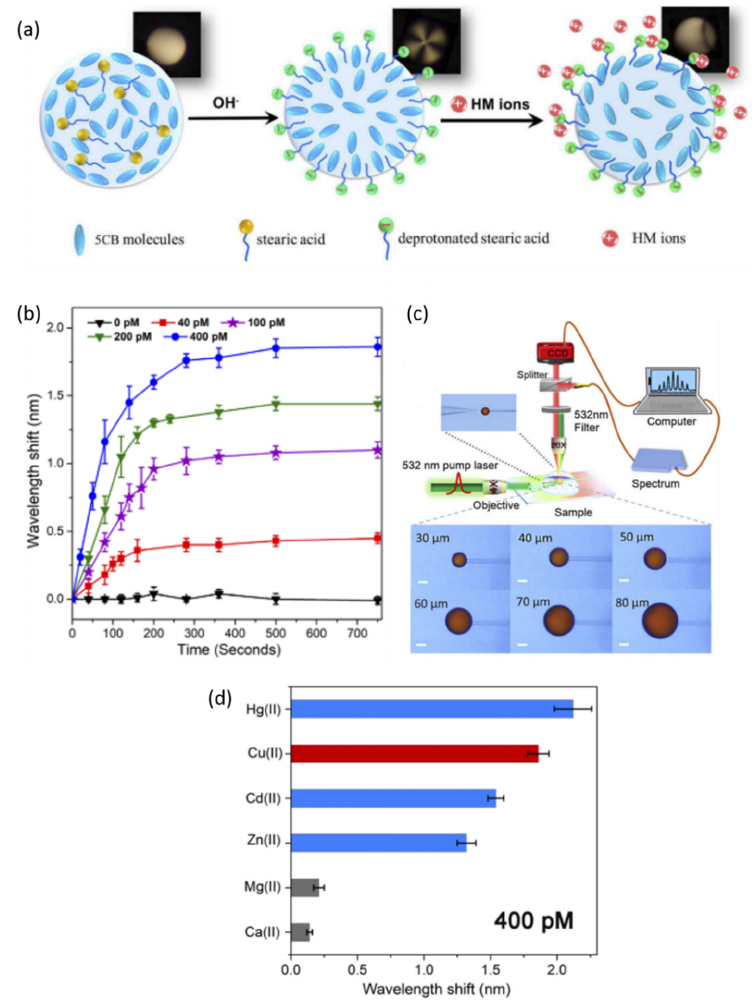
Figure 25. ( a ) Schematic of 5CB microdroplets detecting heavy metal ions. ( b ) Wavelength shifts associated with increasing concentrations of Cu(II) ions. ( c ) Schematic of the experimental setup used for HM ion detection. Droplets are fixed to the capillary connected to a syringe pump to control the droplet size in the medium. It is pumped by the laser shown through a tapered optical fiber. ( d ) specificity results for other heavy metals (blue), Cu(II), and acceptable minerals found in water (gray) at 400 pM concentrations. Reproduced from ref. [119] with permission © The Optical Society of America. Sensors 2020 , 20 , x FOR PEER REVIEW